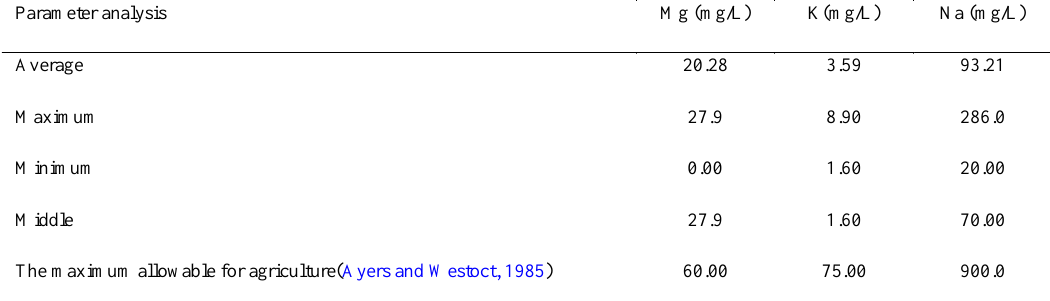
Table 5: The minimum, maximum value cations parameters of groundwater